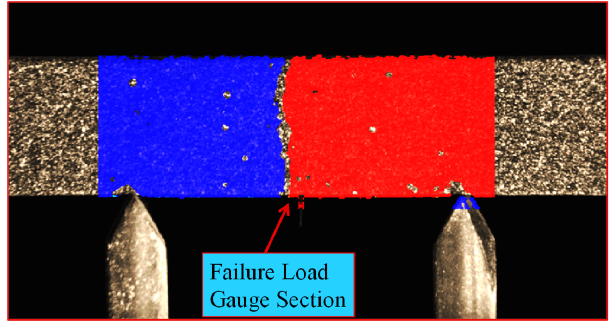
Figure 11. Plot of the strain field of the last image frame before failure at 50% of the ultimate tensile stress (UTS).